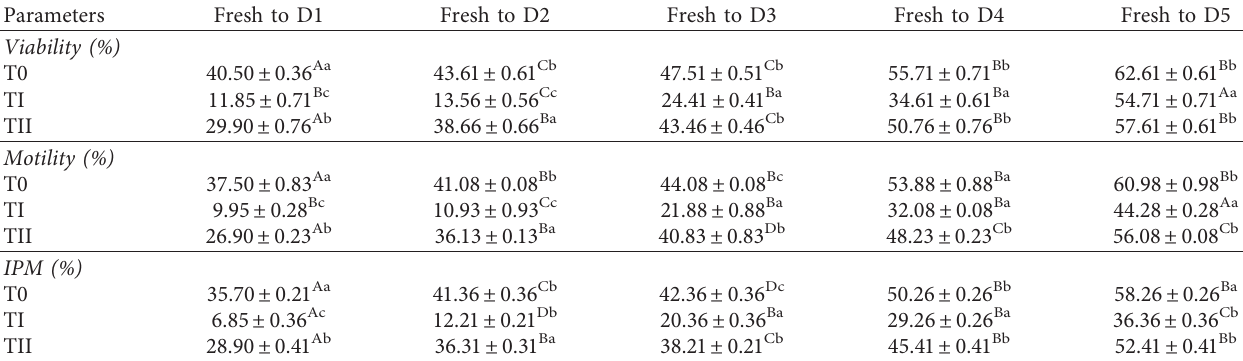
Different capital letter superscripts in the same row and lowercase letter superscripts in the same column indicate significant differences ( p < 0 . 05). SM-EY: skim milk-egg yolk; T0: SM-EY extender without the protein; T1: SM-EY extender +12 μ g protein/100mL extender; T2: SM-EY extender +24 μ g protein/ 100mL extender. Table 4: The average viability, motility, intactness of plasma membrane percentages, MDA concentration, and percentage of apoptotic sperm of Kacang goat sperm stored at 5 ° C for five days in skim milk-egg yolk extender with and without the addition of 150kDa protein isolated from Simmental bull seminal plasma.